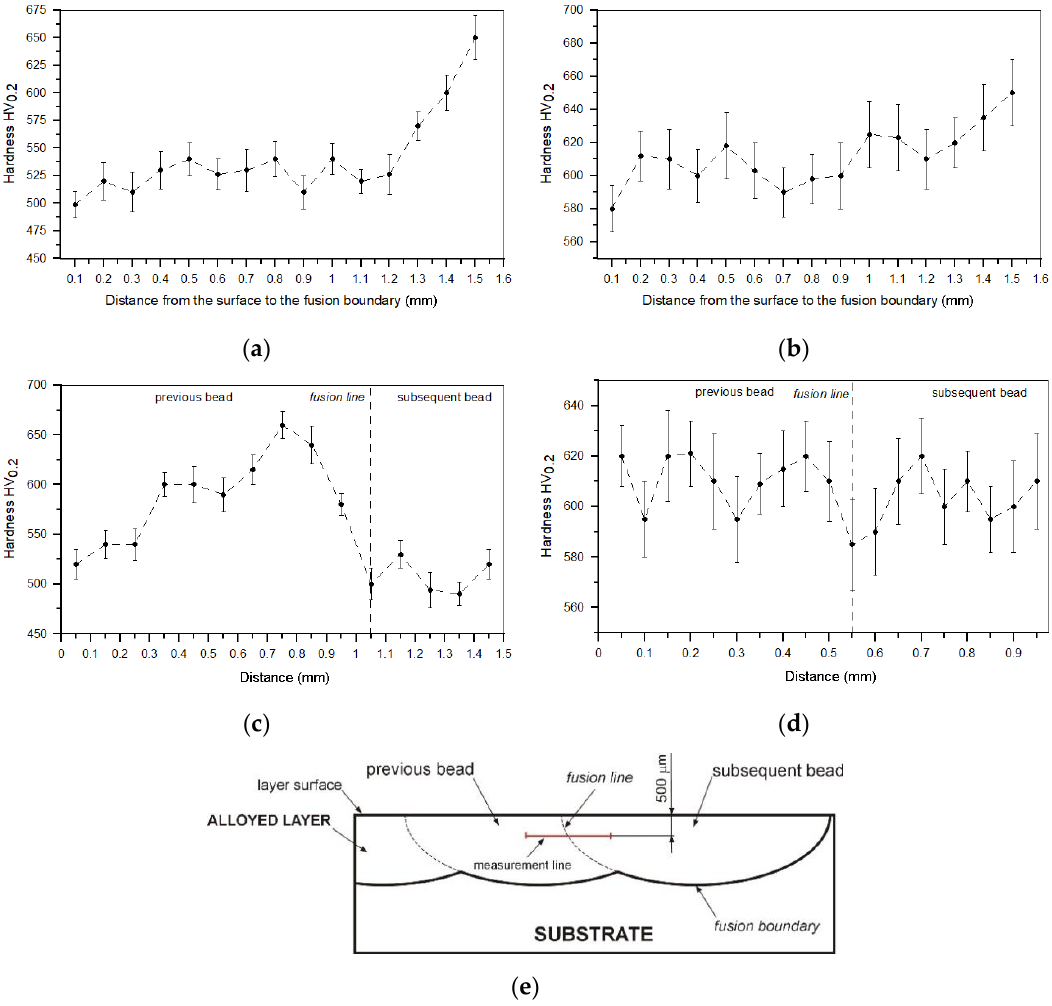
Figure 14. ( a,b ) Hardness depth profiles for TRC and TRM (Table 3), respectively. ( c,d ) Hardness profiles across the overlap boundary between consecutive beads in TRC and TRM, respectively. ( e ) Diagram showing a location of the measurement line in the overlap boundary.